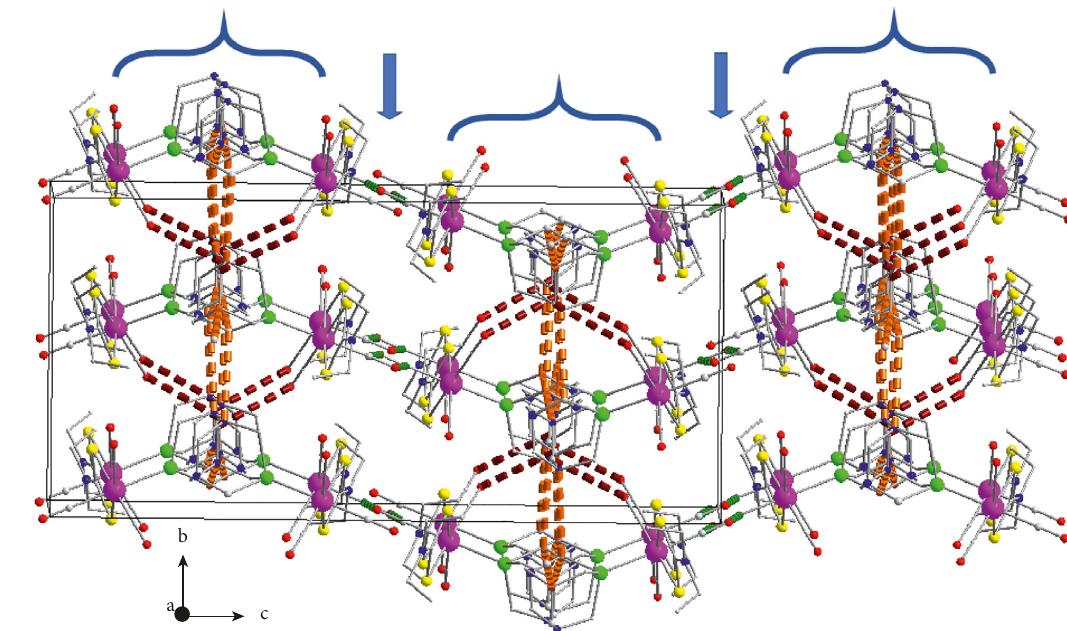
Figure 7: Stacking of layers along the c crystallographic axis in the structure of compound 3a . Braces indicate the position of layers and arrows the carbonyl-carbonyl interactions. The dashed thick orange lines indicate C 9 -H 9 A indicates C 13 -H 13 A O 1 hydrogen bonds. Dashed thick dark green lines indicate antiparallel CO · · · Details for the arrangement of complexes and the intermolecular interactions within the layer are presented in Figure S3.